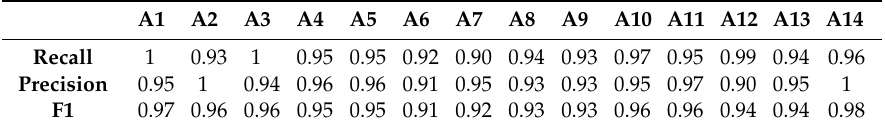
Table 2. Classification recall, precision, and F1 of the Cornell Activity Dataset (CAD) 60 dataset.